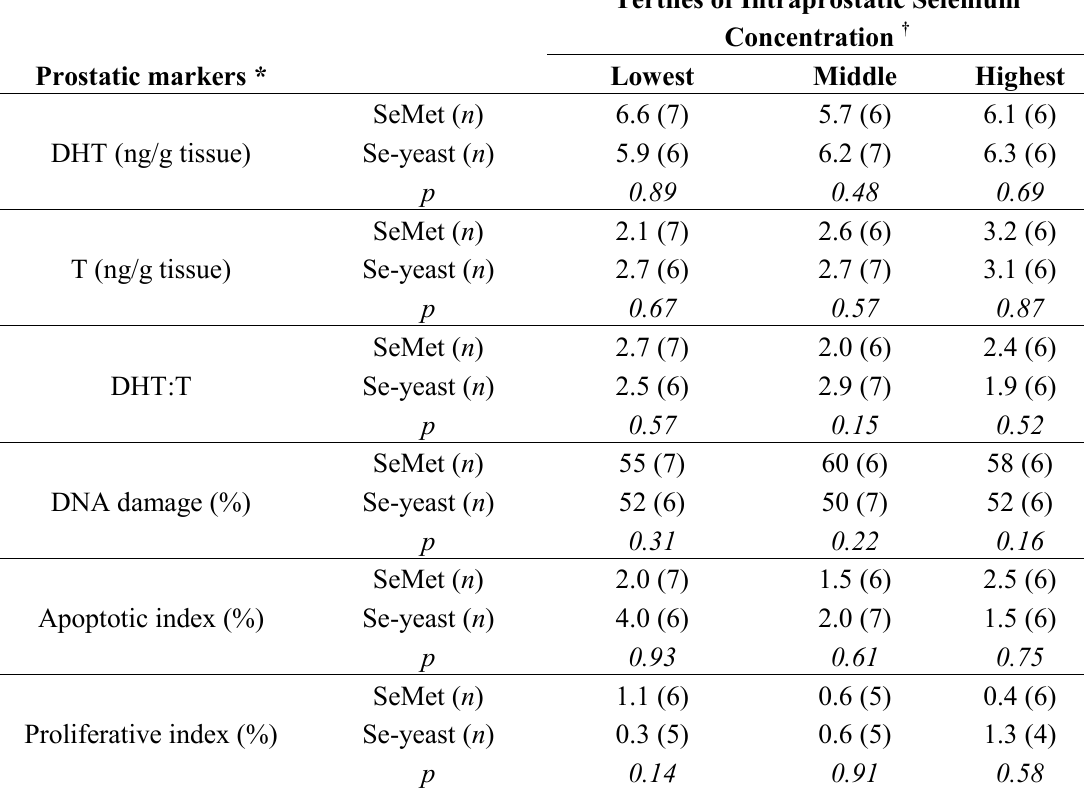
Table 1. Prostatic response to selenomethionine (SeMet) vs. selenium-yeast (Se-yeast): analysis of target tissue potency using markers of prostatic